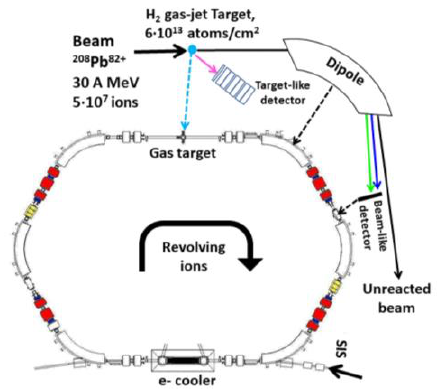
Fig. 2. The lower part shows the ESR and the upper part the setup used in our experiment. The trajectory of the scattered protons is shown in pink. The trajectories of the beam-like residues produced after  - ray ( 208 Pb 82+ ) and neutron emission ( 207 Pb 82+ ) are shown in blue and green,